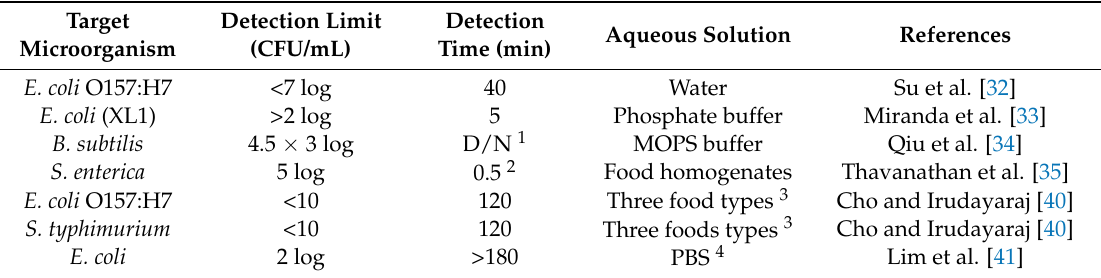
Table 2. Representative research on colorimetric assays coupled with Au nanoparticles for pathogenic bacteria detection.